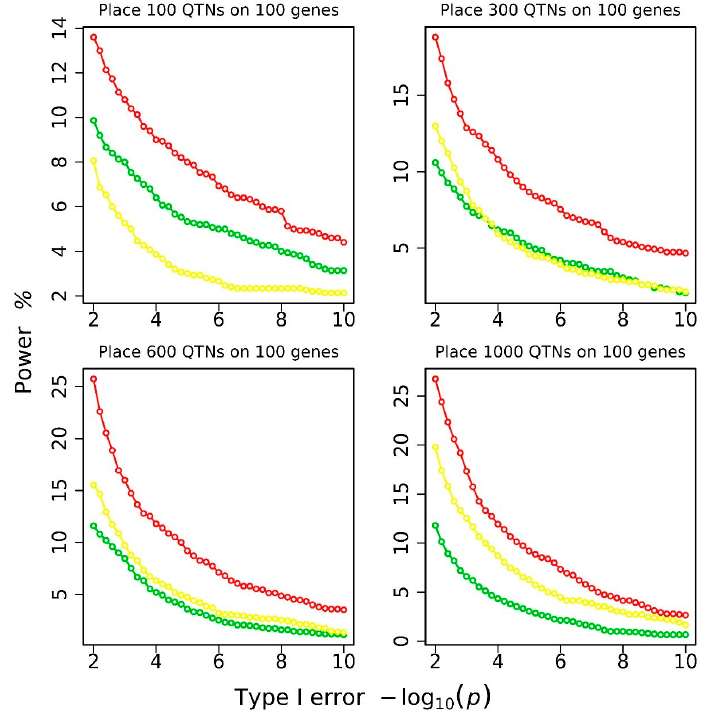
Figure 3. Statistical power versus different levels of type-I error for groups of 100, 300, 600, and 1000 QTNs. The green color represents ALLSNP, yellow represents FPC, red represents EPC.